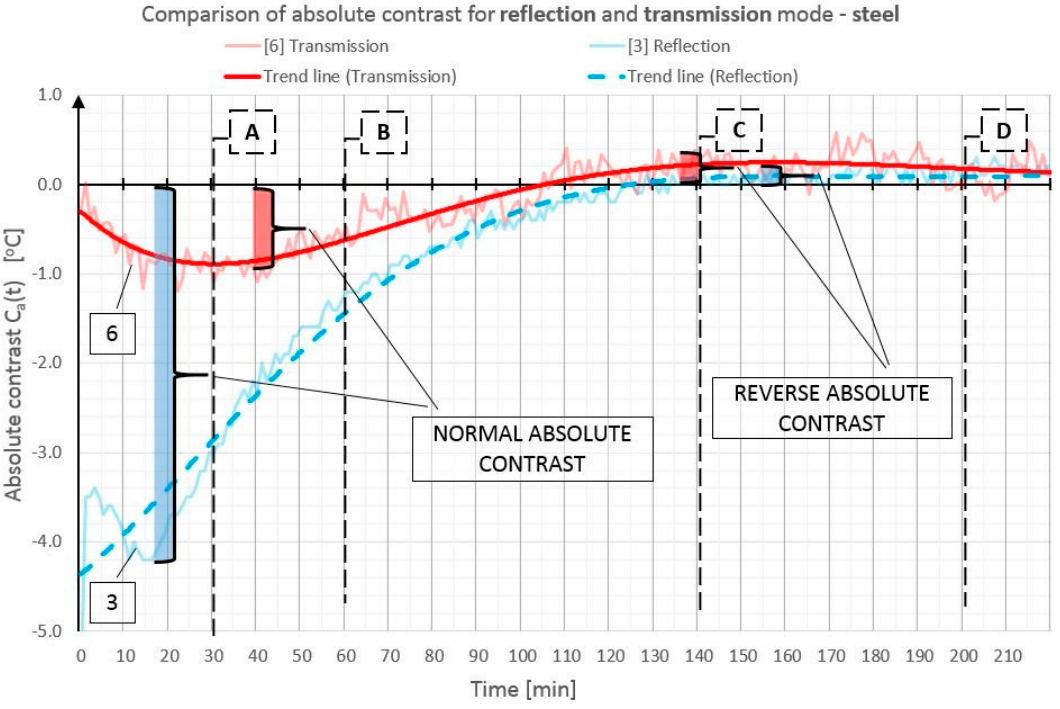
Figure 15. Diagram of absolute contrast in a reflection mode and in a transmission mode for steel inclusion, with marked places where normal absolute contrast and inverse absolute contrast occur (heating from a distance of 1.5 m).